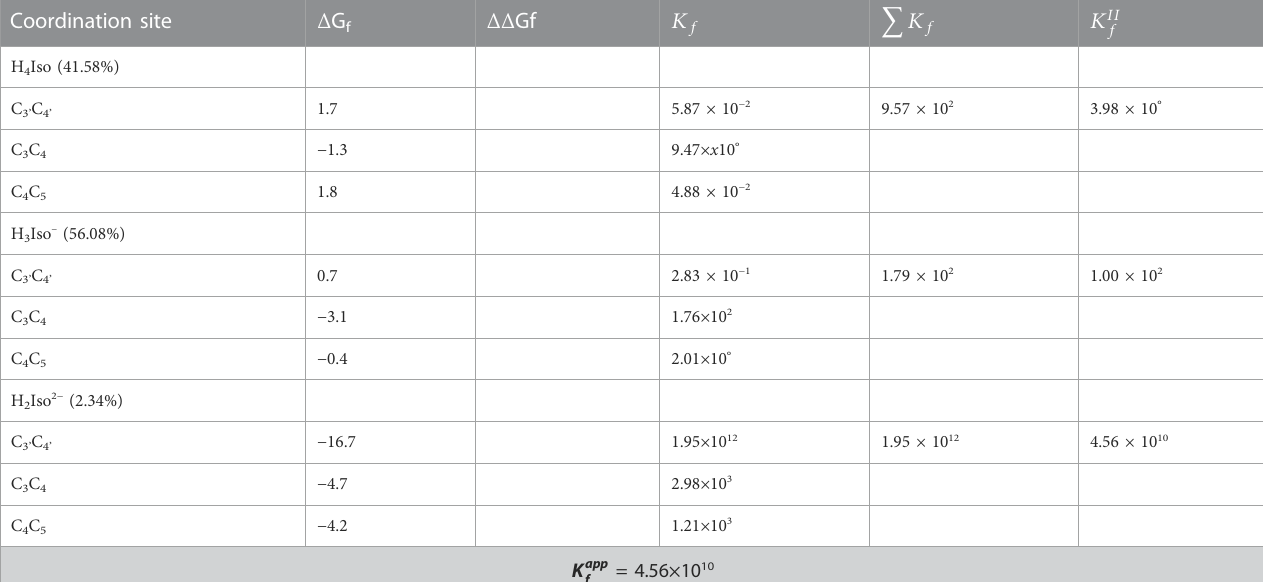
TABLE 5 Gibbs formation energies ( Δ G f ), their differences ( ΔΔ G f ), both in kcal/mol, and kinetic constants ( K f , (cid:4) K f , K II f , and K app i in M − 1 s − 1 ) for the different coordination sites of isorhamnetin with Cu(II) ion in 1: 1 ratio. Coordination